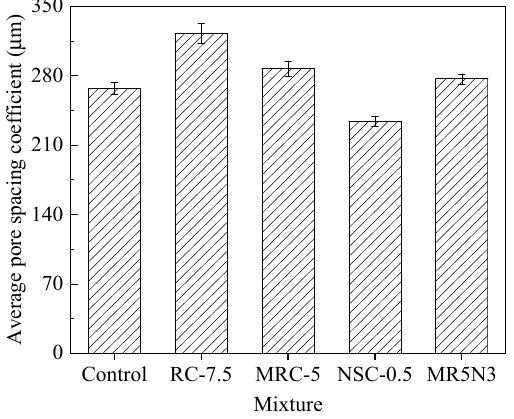
Figure 15. Average pore spacing coefficient of concrete.